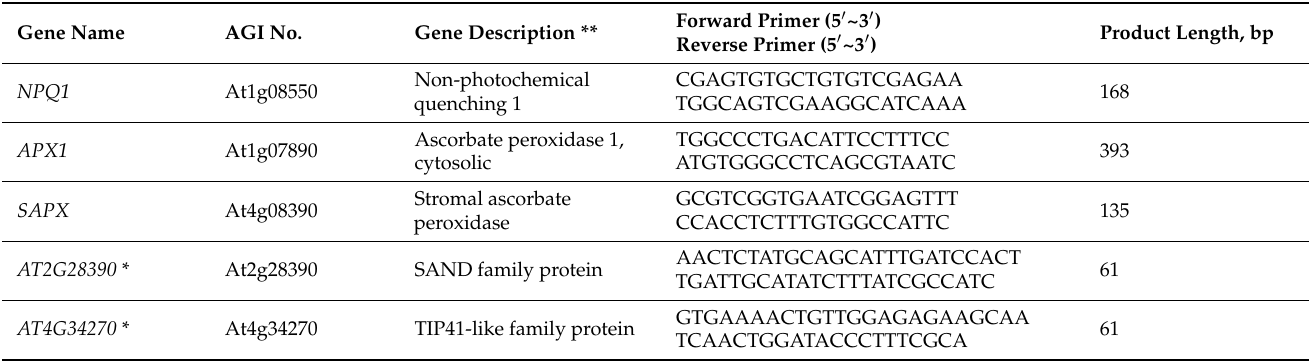
Table 1. A list of primer sets for qRT-PCR